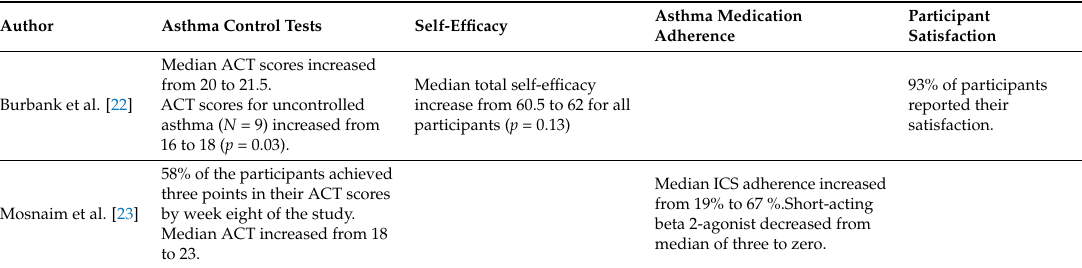
Table 3. Outcomes measured by the included intervention